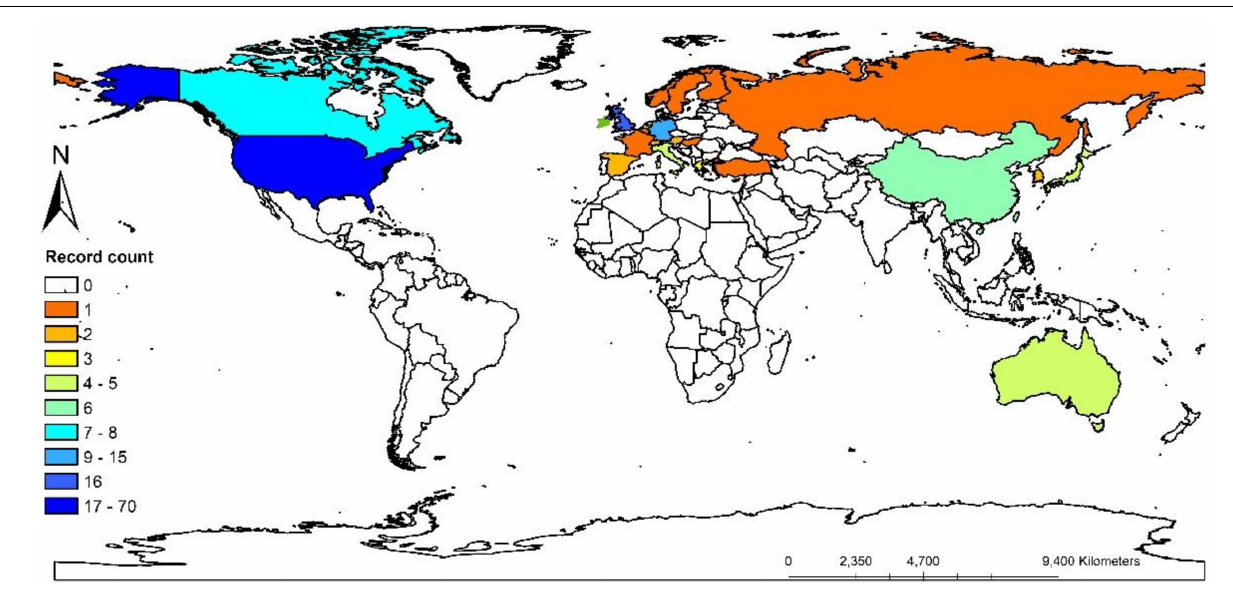
FIGURE 5 | Global distribution record counts of highly cited